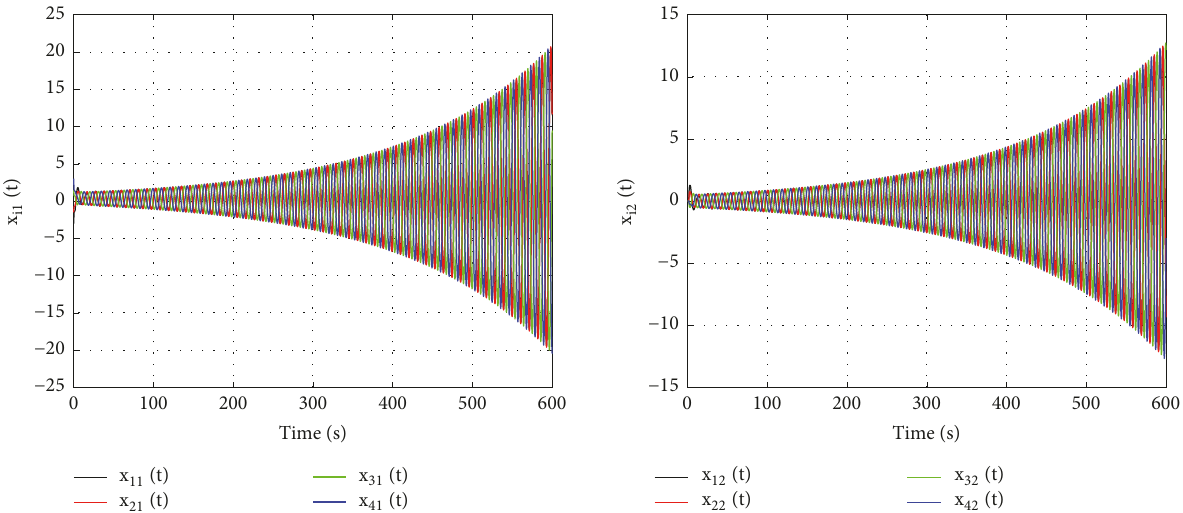
Figure 10: The trajectories of all agents’ states in the FOMAS with double integral and asymmetric time-delays when all 𝜏 𝑚 > 𝜏 in Example